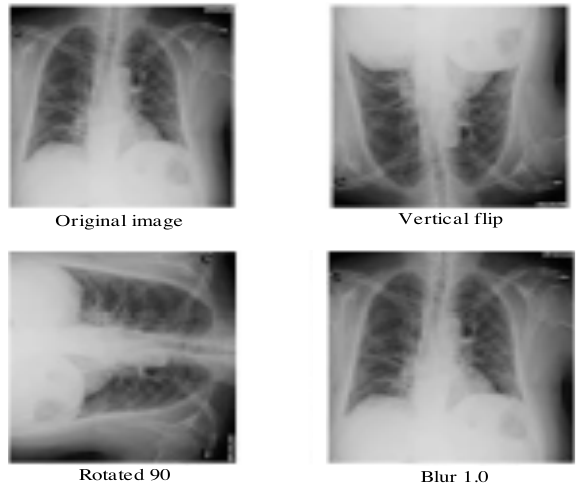
Figure 3. Illustrative examples of augmented Chest X-Rays with COVID-19 from the dataset [44].